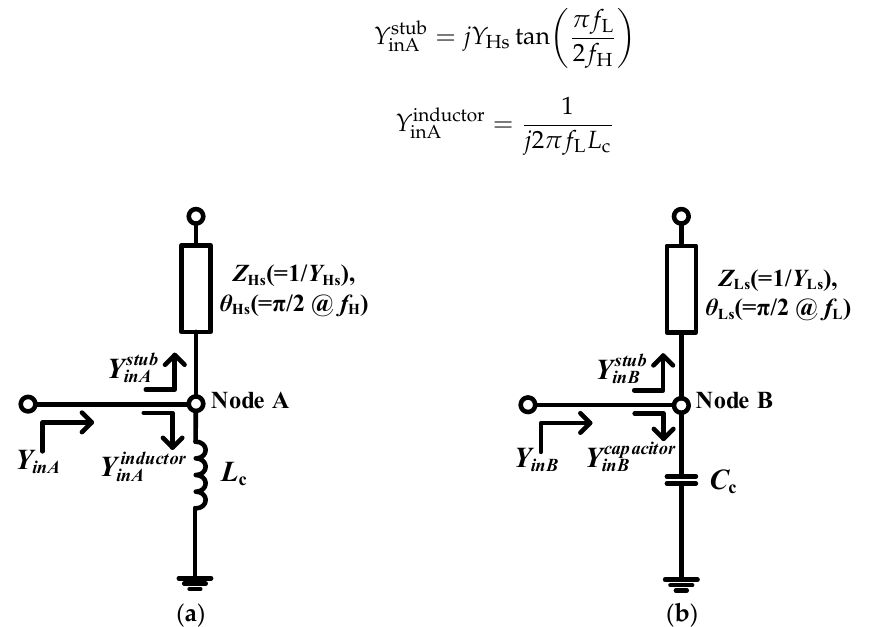
Figure 2. Compensation method according to operating band: ( a ) Low-band operation; ( b ) High-band operation.